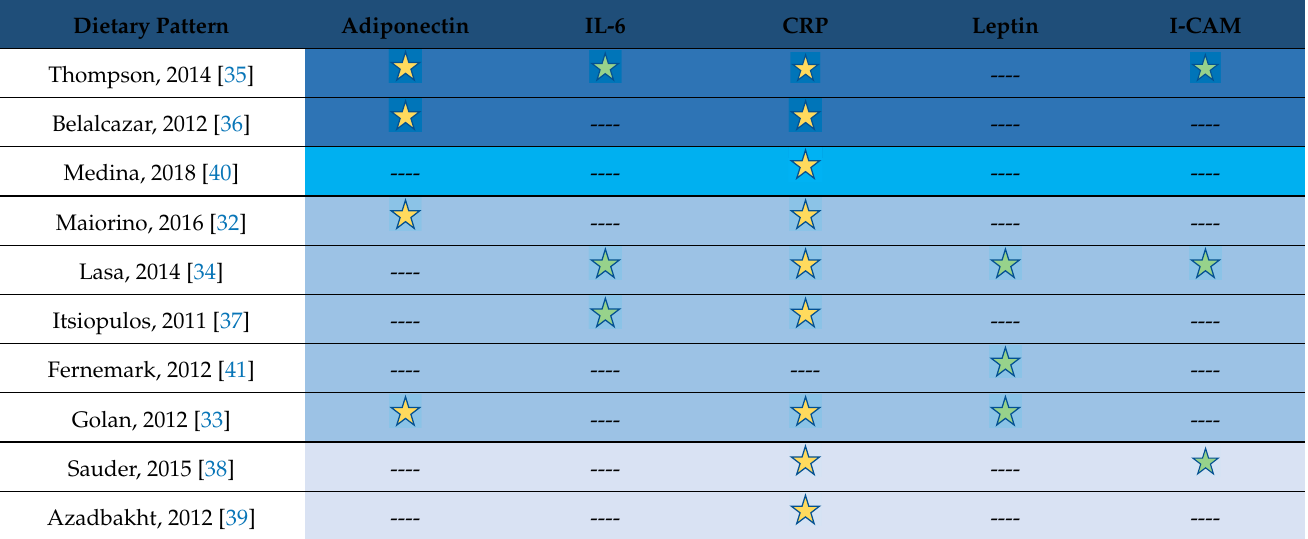
---- ---- ---- Studies were clustered by results, and s imilar features were summarized according to biomarkers of inflammation more frequently utilized in RCTs, grouping each DP. The CP cluster included rec- Studies were clustered by results, and s imilar features were summarized according to biomarkers ommendations by the American Heart Association and DASH diet, and the DE group included DPP of inflammation more frequently utilized in RCTs, grouping each DP. The CP cluster included rec- and the Diabetes UK healthy eating guidelines. Adiponectin and CRP values marked in yellow color and the Diabetes UK healthy eating guidelines. Adiponectin and CRP values marked in yellow color ommendations by the American Heart Association and DASH diet, and the DE group included DPP were used for meta-analysis. Other values marked in green color were not calculated in the meta- were used for meta-analysis. Other values marked in green color were not calculated in the meta- and the Diabetes UK healthy eating guidelines. Adiponectin and CRP values marked in yellow color Studies were clustered by results, and s imilar features were summarized according to biomarkers analysis due to insufficient studies. Abbreviations: AD , anti-inflammatory diet; CRP, C-reactive analysis due to insufficient studies. Abbreviations: AD , anti-inflammatory diet; CRP, C-reactive were used for meta-analysis. Other values marked in green color were not calculated in the meta- of inflammation more frequently utilized in RCTs, grouping each DP. The CP cluster included rec- protein; CP , Cardio Protective; DASH, Dietary Approaches to Stop Hypertension; ICAM-1, in- Studies were clustered by results, and s imilar features were summarized according to biomarkers analysis due to insufficient studies. Abbreviations: AD , anti-inflammatory diet; CRP, C-reactive ommendations by the American Heart Association and DASH diet, and the DE group included DPP tercellular adhesion molecule; IL-6, interleukin-6; MD , Mediterranean diet; DE , specialized of inflammation more frequently utilized in RCTs, grouping each DP. The CP cluster included rec- protein; CP , Cardio Protective; DASH, Dietary Approaches to Stop Hypertension; ICAM-1, in- and the Diabetes UK healthy eating guidelines. Adiponectin and CRP values marked in yellow color diet for subjects with diabetes. ---- ommendations by the American Heart Association and DASH diet, and the DE group included DPP tercellular adhesion molecule; IL-6, interleukin-6; MD , Mediterranean diet; DE , specialized were used for meta-analysis. Other values marked in green color were not calculated in the meta- and the Diabetes UK healthy eating guidelines. Adiponectin and CRP values marked in yellow color diet for subjects with diabetes. analysis due to insufficient studies. Abbreviations: AD , anti-inflammatory diet; CRP, C-reactive Studies were clustered by results, and s imilar features were summarized according to biomarkers Studies were clustered by results, and s imilar features were summarized according to biomarkers were used for meta-analysis. Other values marked in green color were not calculated in the meta- of inflammation more frequently utilized in RCTs, grouping each DP. The CP cluster included rec- protein; CP , Cardio Protective; DASH, Dietary Approaches to Stop Hypertension; ICAM-1, in- of inflammation more frequently utilized in RCTs, grouping each DP. The CP cluster included rec- analysis due to insufficient studies. Abbreviations: AD , anti-inflammatory diet; CRP, C-reactive ommendations by the American Heart Association and DASH diet, and the DE group included DPP ommendations by the American Heart Association and DASH diet, and the DE group included DPP tercellular adhesion molecule; IL-6, interleukin-6; MD , Mediterranean diet; DE , specialized and the Diabetes UK healthy eating guidelines. Adiponectin and CRP values marked in yellow color protein; CP , Cardio Protective; DASH, Dietary Approaches to Stop Hypertension; ICAM-1, in- protein; CP , Cardio Protective; DASH, Dietary Approaches to Stop Hypertension; ICAM-1, in- and the Diabetes UK healthy eating guidelines. Adiponectin and CRP values marked in yellow color diet for subjects with diabetes. were used for meta-analysis. Other values marked in green color were not calculated in the meta- tercellular adhesion molecule; IL-6, interleukin-6; MD , Mediterranean diet; DE , specialized tercellular adhesion molecule; IL-6, interleukin-6; MD , Mediterranean diet; DE , specialized were used for meta-analysis. Other values marked in green color were not calculated in the meta- analysis due to insufficient studies. Abbreviations: AD , anti-inflammatory diet; CRP, C-reactive diet for subjects with diabetes. diet for subjects with diabetes. analysis due to insufficient studies. Abbreviations: AD , anti-inflammatory diet; CRP, C-reactive protein; CP , Cardio Protective; DASH, Dietary Approaches to Stop Hypertension; ICAM-1, in- protein; CP , Cardio Protective; DASH, Dietary Approaches to Stop Hypertension; ICAM-1, in- tercellular adhesion molecule; IL-6, interleukin-6; MD , Mediterranean diet; DE , specialized tercellular adhesion molecule; IL-6, interleukin-6; MD , Mediterranean diet; DE , specialized diet for subjects with diabetes. diet for subjects with diabetes. 3.3.2. Meta-Analysis A total of eight RCTs were included in the meta-analysis. In our linear analysis, we included and analyzed outcome measures provided by five different trials [32–36] for ad- iponectin and seven studies for CRP [32,33,35–39]. The biomarkers TNF- α [34], IL-6